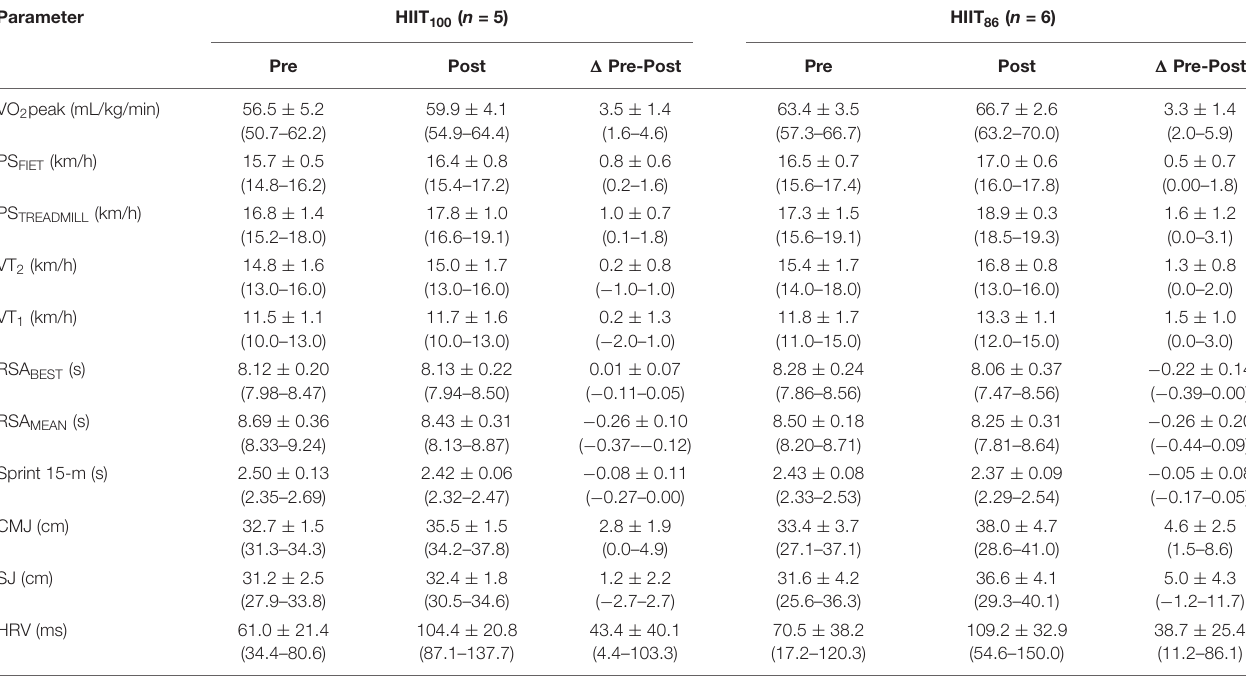
TABLE 1 | Observed means ± SD (minimum – maximum) of physiological, and performance parameters of futsal players in each HIIT model pre and post ten weeks of training and the changes.